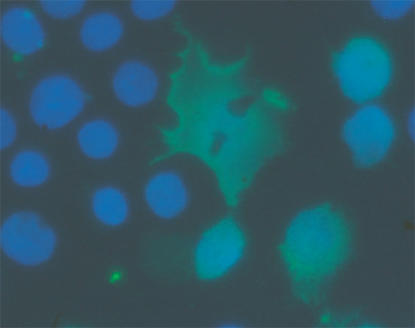
IL-1 causes nuclear membrane breakdown in rat insulinoma cells